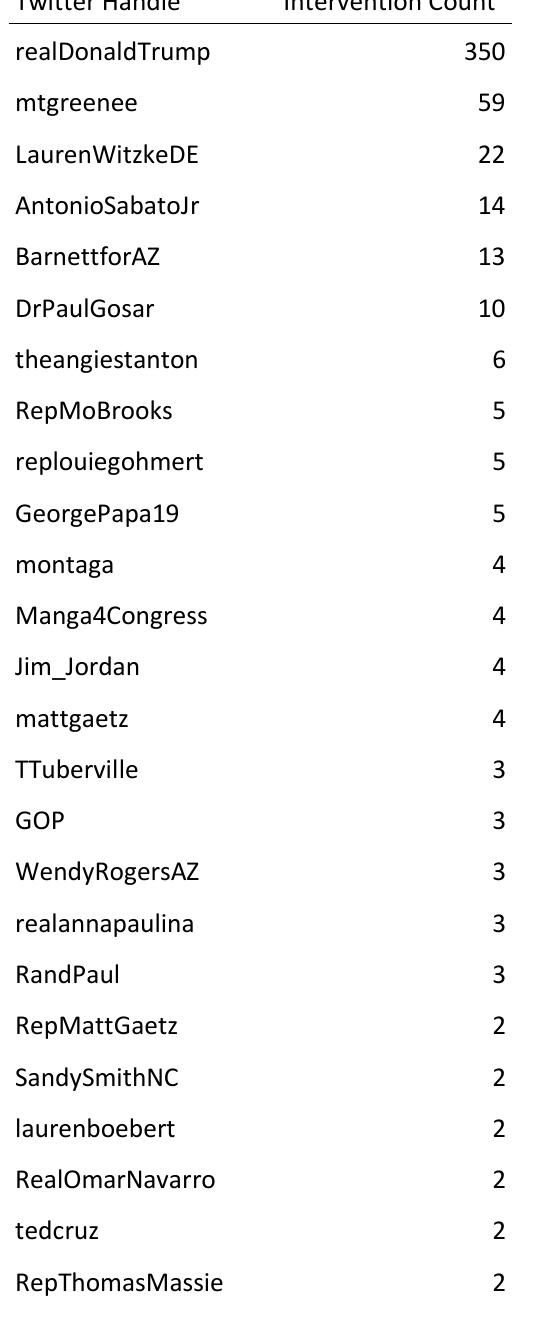
Table 1. Number of Interventions by politician (by those that received >1